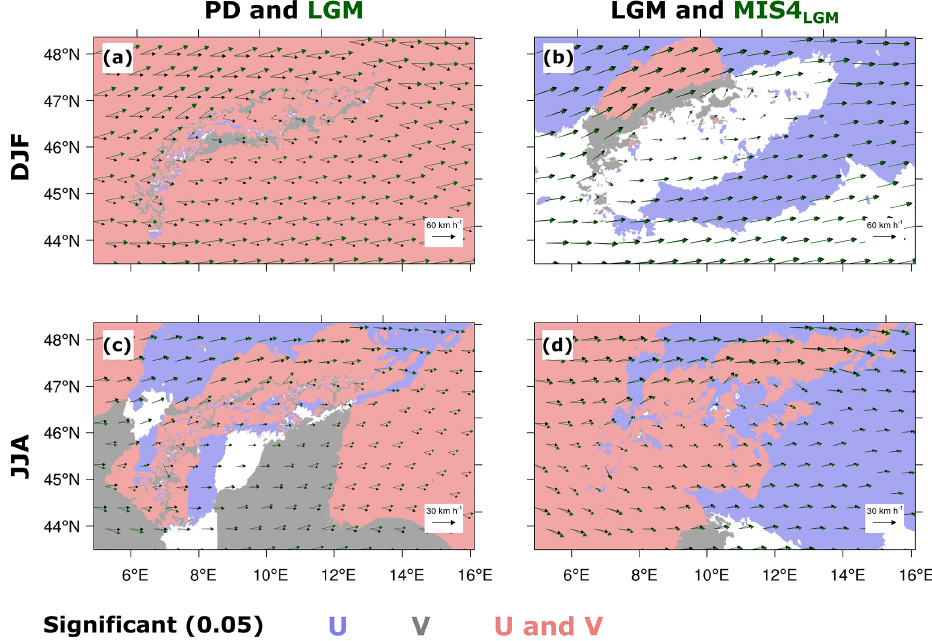
Figure 5. Climatological mean wind vectors over the Alps for (a, b) DJF and (c, d) JJA: (a, c) black and green wind vectors correspond to PD and LGM, respectively, (b, d) black and green wind vectors correspond to LGM and MIS4, respectively. Red shading illustrates statis- tically significant differences in zonal ( U ) and meridional ( V ) wind components with a significance level of 0.05 (two-tailed bootstrapping technique), blue and grey shadings indicate significance either in the U or V wind component, respectively. Please note that the reference wind vectors differ for DJF and